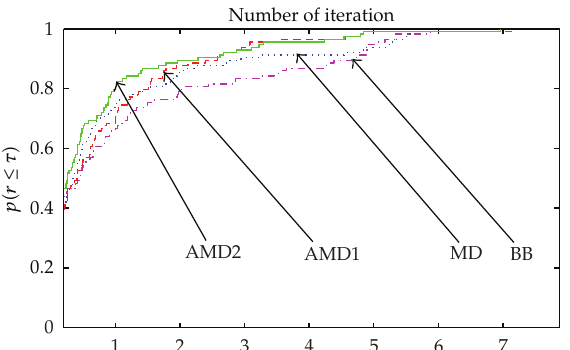
Figure 1: Performance profile based on Iteration for all problems.